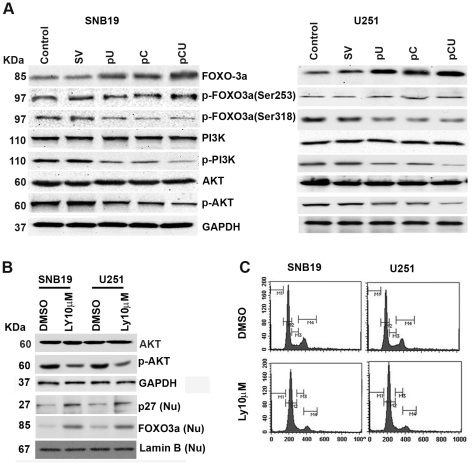
Cathepsin B and uPAR knockdown induces FOXO3a expression and translocation to the nucleus by inhibiting PI3K activity.
A. After transfection, cell lysates were collected from the untreated control and SV, pU, pC or pCU-treated cells. Equal volume of total protein was blotted for the expression of PI3K, p-PI3K, AKT, p-AKT, FOXO3a, p-FOXO3a (253), and p-FOXO3a (Ser 318). B. SNB19 and U251 cells were treated with either DMSO or LY294002 (Ly 10 µM) for 24 hrs as mentioned in the Materials and Methods. After incubation, the total and nuclear lysates were collected and probed for the expression of p-AKT, p27Kip1 (Nu), FOXO3a (Nu) and lamin B (Nu). Equal loading was confirmed by the GAPDH expression in the total cell lysate. C. After treatments with DMSO- and LY294002- cells were fixed, stained with propidium iodide and subjected to FACS analysis to determine cell cycle status.